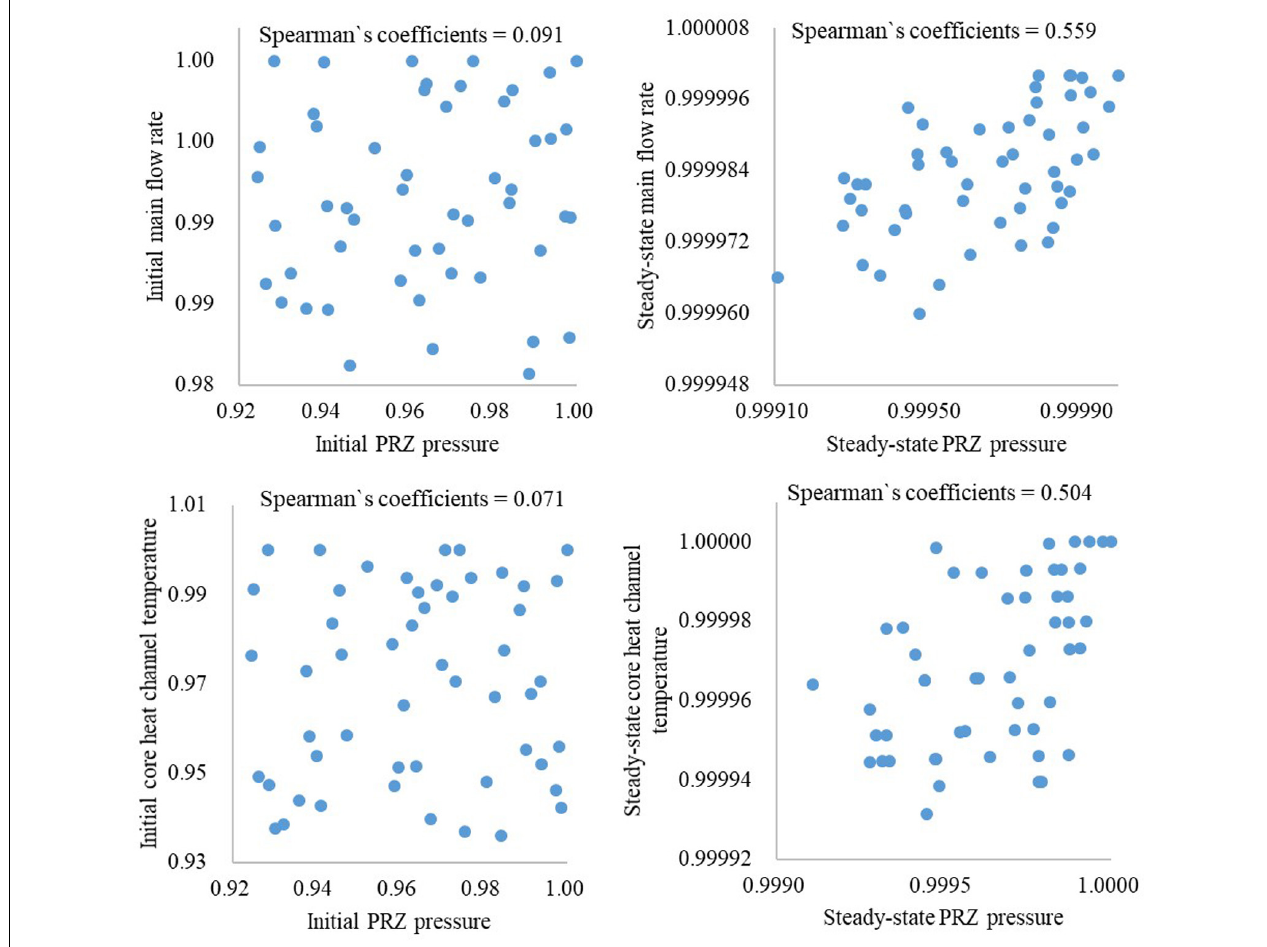
FIGURE 9 | The relationship between initial and steady-state input